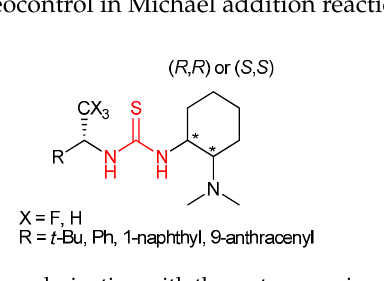
Figure 10. Thiourea derivative with three stereogenic centers [172].